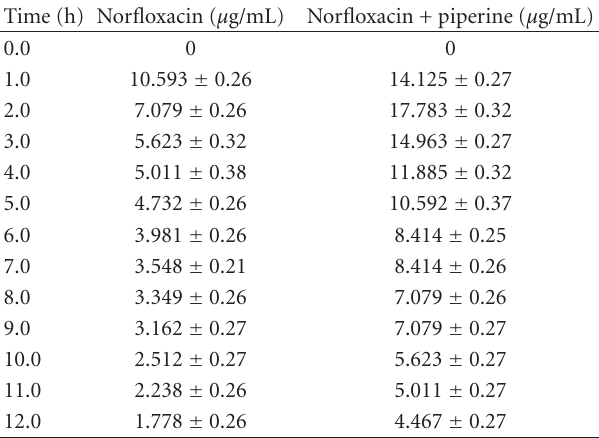
Table 13: E ff ect of piperine on plasma concentration of norfloxacin in rabbits